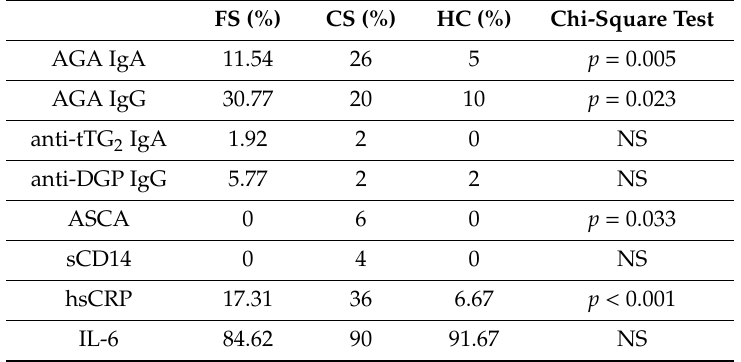
Table 3. The proportion of individuals with elevated concentrations of gluten sensitivity and inflammatory markers across the examined